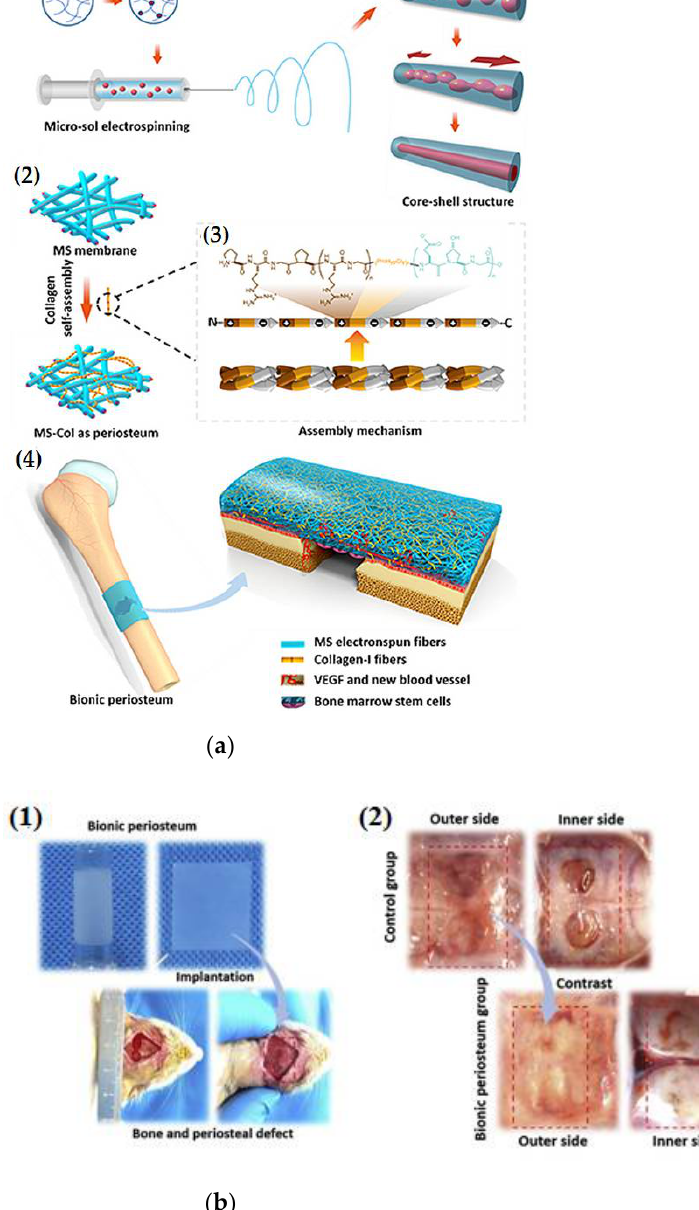
Figure 4. Schematic illustration ( a ) (1) The fabrication of VEGF-loaded electrospinning membranes by hyaluronan (HA) micro-sol electrospinning and the mechanism of formation of core-shell structure. (2) The building process of the hierarchical micro/nanofibrous structure along with (3) the illustration of assembly mechanism and (4) bionic periosteum for periosteal and bone regeneration, and ( b ) General evaluation of in vivo performance. (1) Images represent the critical bone and periosteal defect model and implantation of bionic periosteum with good operability, and (2) Images represent the contrast between bionic periosteum and control group from the outer and inner side of skull specimens (reproduced from [81] with permission of Elsevier, 2019).